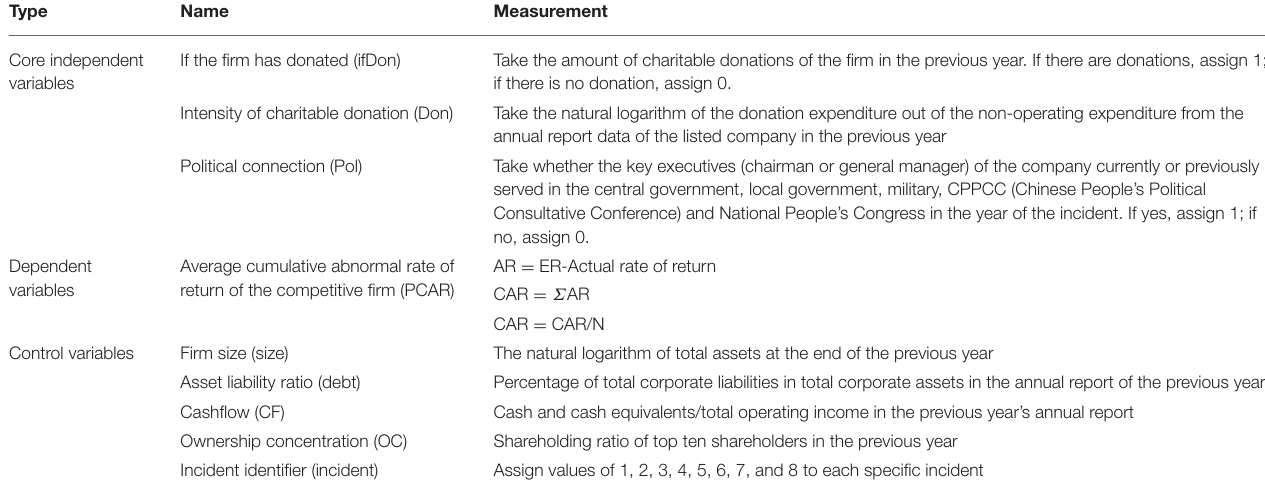
TABLE 1 | Description of the research